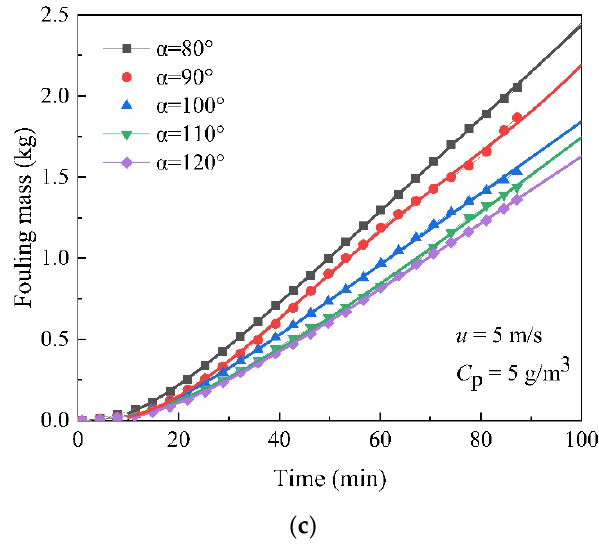
Figure 19. Particle deposition mass, removal mass, and fouling mass versus time for the different angle α. ( a ) Deposition mass; ( b ) Removal mass; ( c ) Fouling mass.